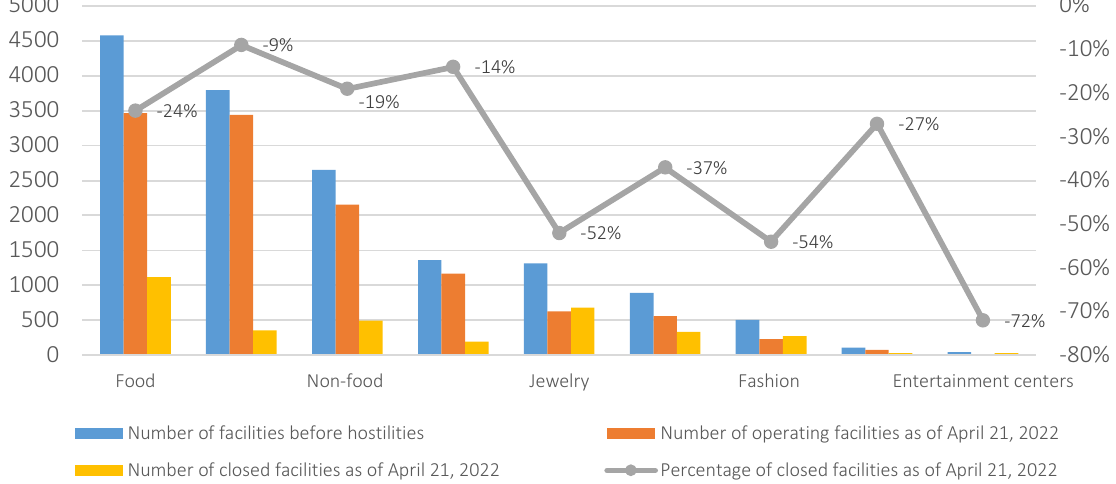
Figure 2. Estimating existing/closed retail facilities as of April 21,